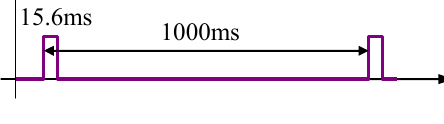
Figure 5 . Wave form of Enable